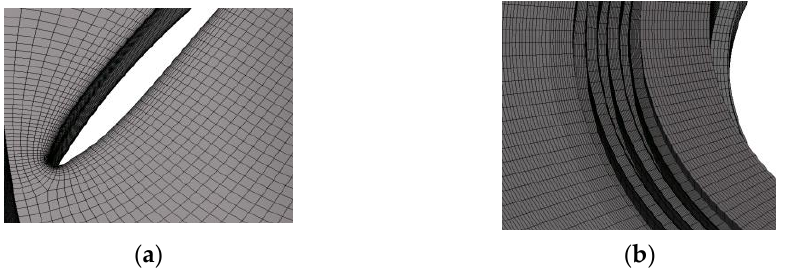
Figure 2. Parts of the mesh in the runner and the upper crown seal gap. ( a ) Refinement of the blade surface mesh ( b ) Refinement of the gap labyrinth ring mesh.